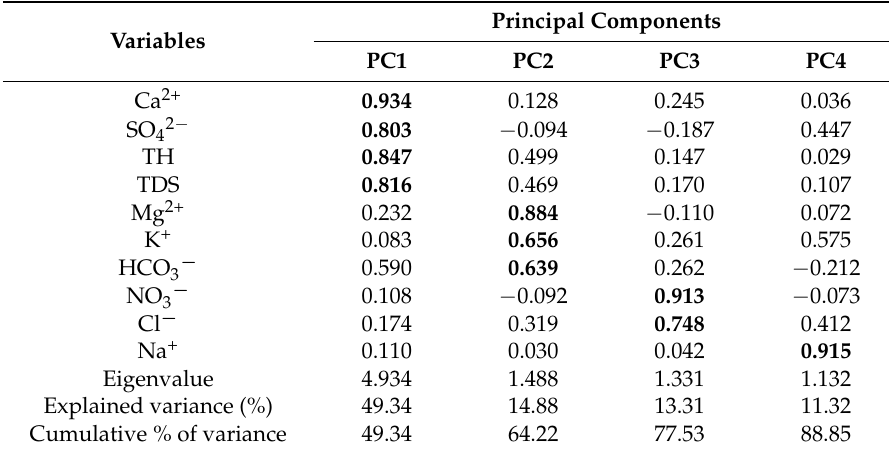
Table 3. Loadings for varimax rotated factor matrix of chemical datasheet (significant loadings are marked in